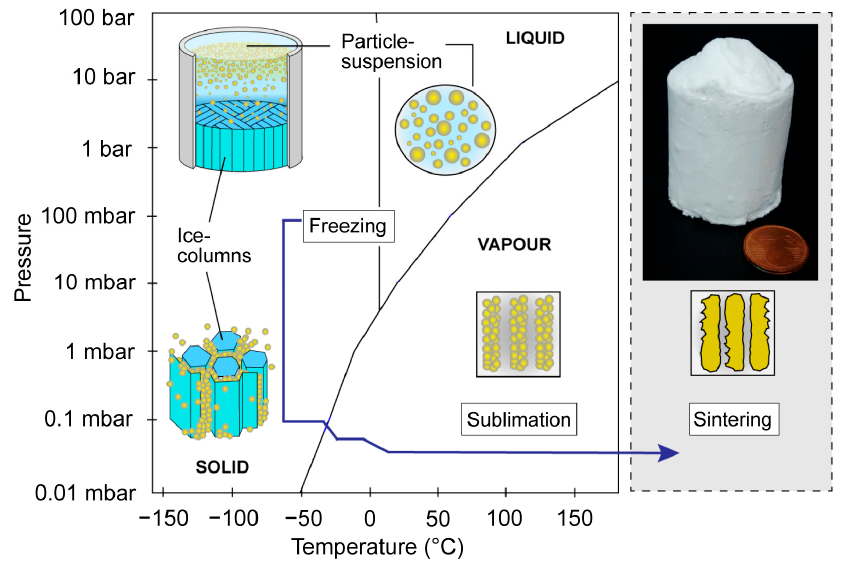
Figure 2. Schematic overview of the freeze-casting process with four main processing steps: prepara- tion of the suspension, solidification via freezing, sublimation and sintering.